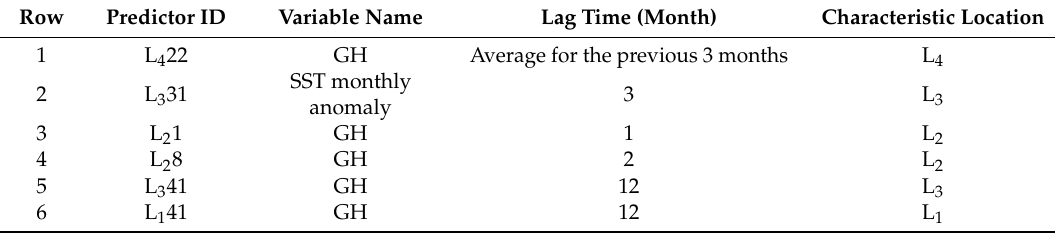
Table 8. List of the variables as criteria in TOPSIS model with the best simulation performance for forecasting RMAX.